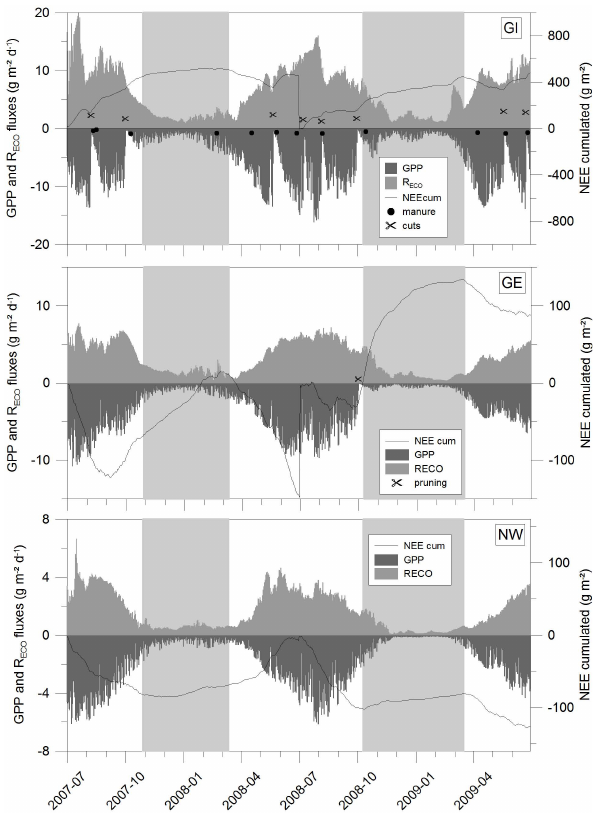
Fig. 3. Modelled CO 2 exchange during 2yr of measurement. R ECO is above, GPP below zero at the left y-scale. The black line refers to cumulative NEE, which is displayed at the right y-scale. After one year (end of June 2008), NEE is reset to zero. White background represents the growing season; grey background the non-growing season.